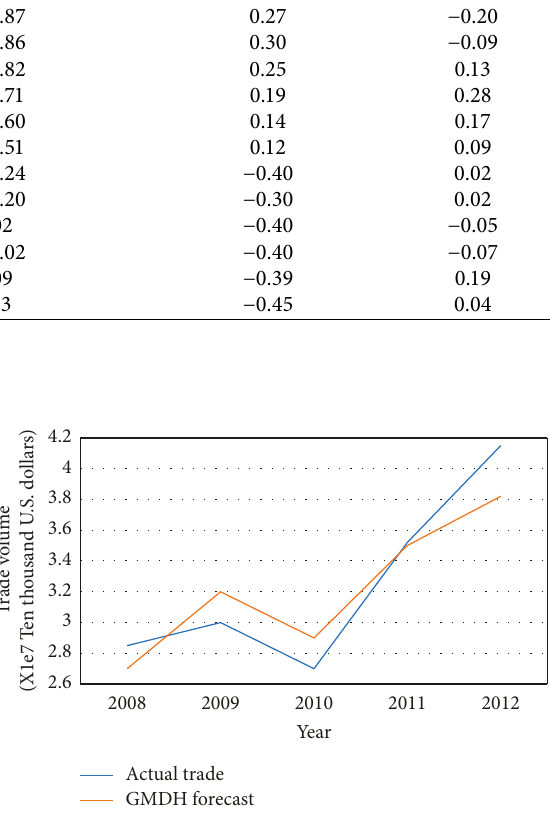
Figure 5: GMDH forecast.